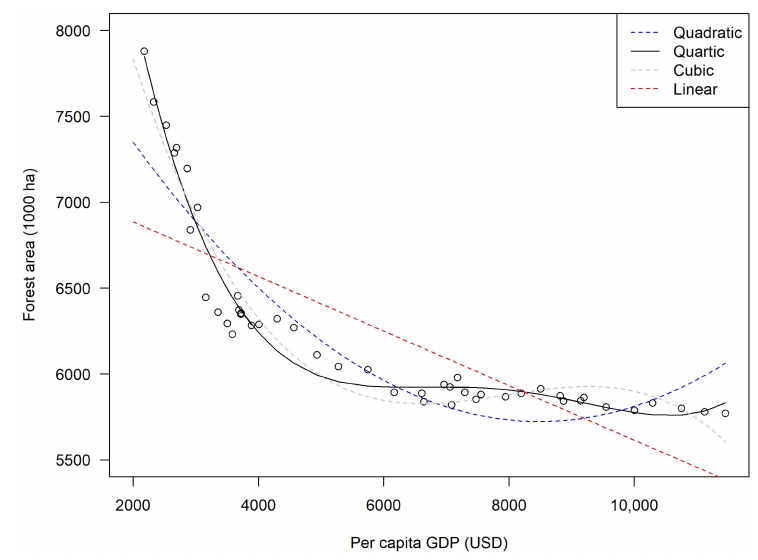
Figure 3. Land areas of forest, oil palm, and rubber plantations. Source: Forestry